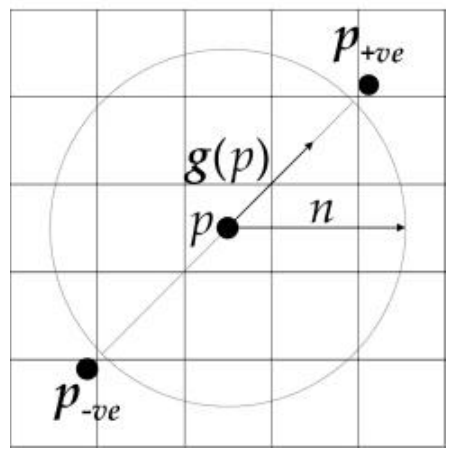
Figure 4. Schematic map of the positively affected pixel and the negatively affected pixel. At each radius n , an orientation projection image O n and a magnitude projection image M n are formed. For each pair of affected pixels, the corresponding point p +ve in the orientation projection image O n and magnitude projection image M n is incremented by 1 and || g ( p )||, respectively, while the point corresponding to p − ve is decremented by these same quantities in each image (the orientation and magnitude projection images are initially zero). That is: